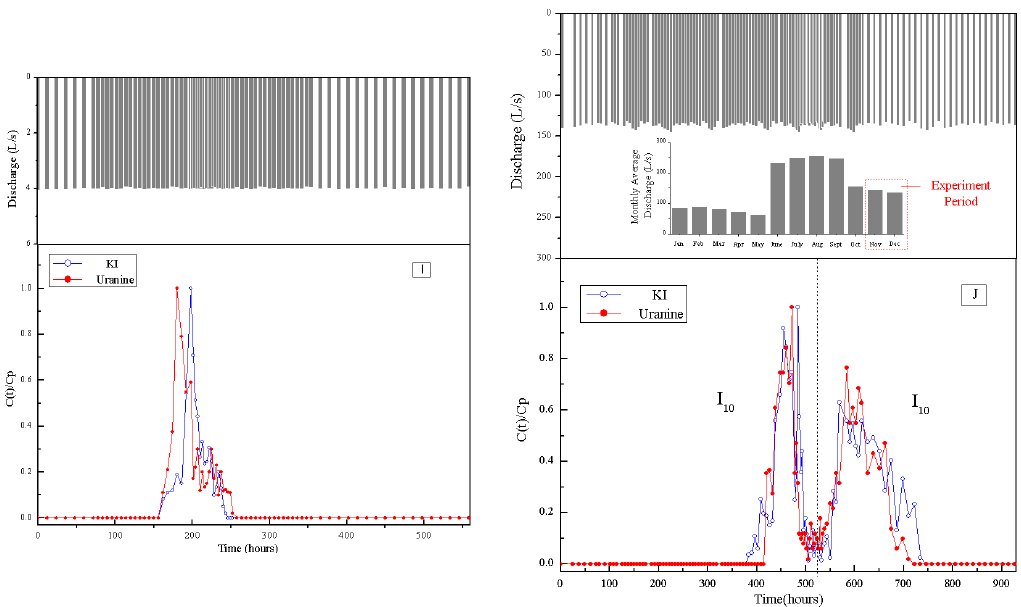
Figure 2. Breakthrough curves of tracer concentration (KI and Uranine) in every receiving point. The ratio of concentration to the maximum shown as C(t)/Cp: ( A – C ) S1, S2 and S3 located in Black Dragon Pool; ( D ) S4 discharging into the Clear Reservoir; ( E – G ) S5, S6 and S7 located in Ancient City; ( H , I ) S8 and S9 distributing along F1; and ( J ) S10 discharging into the White River.